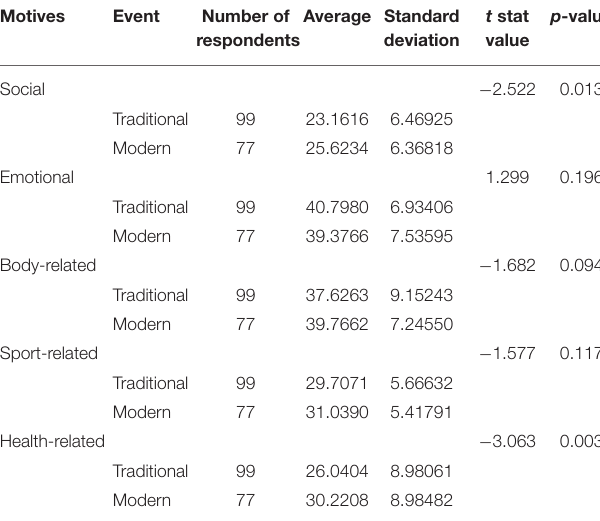
TABLE 17 | Men vs. women in modern water events. Motives